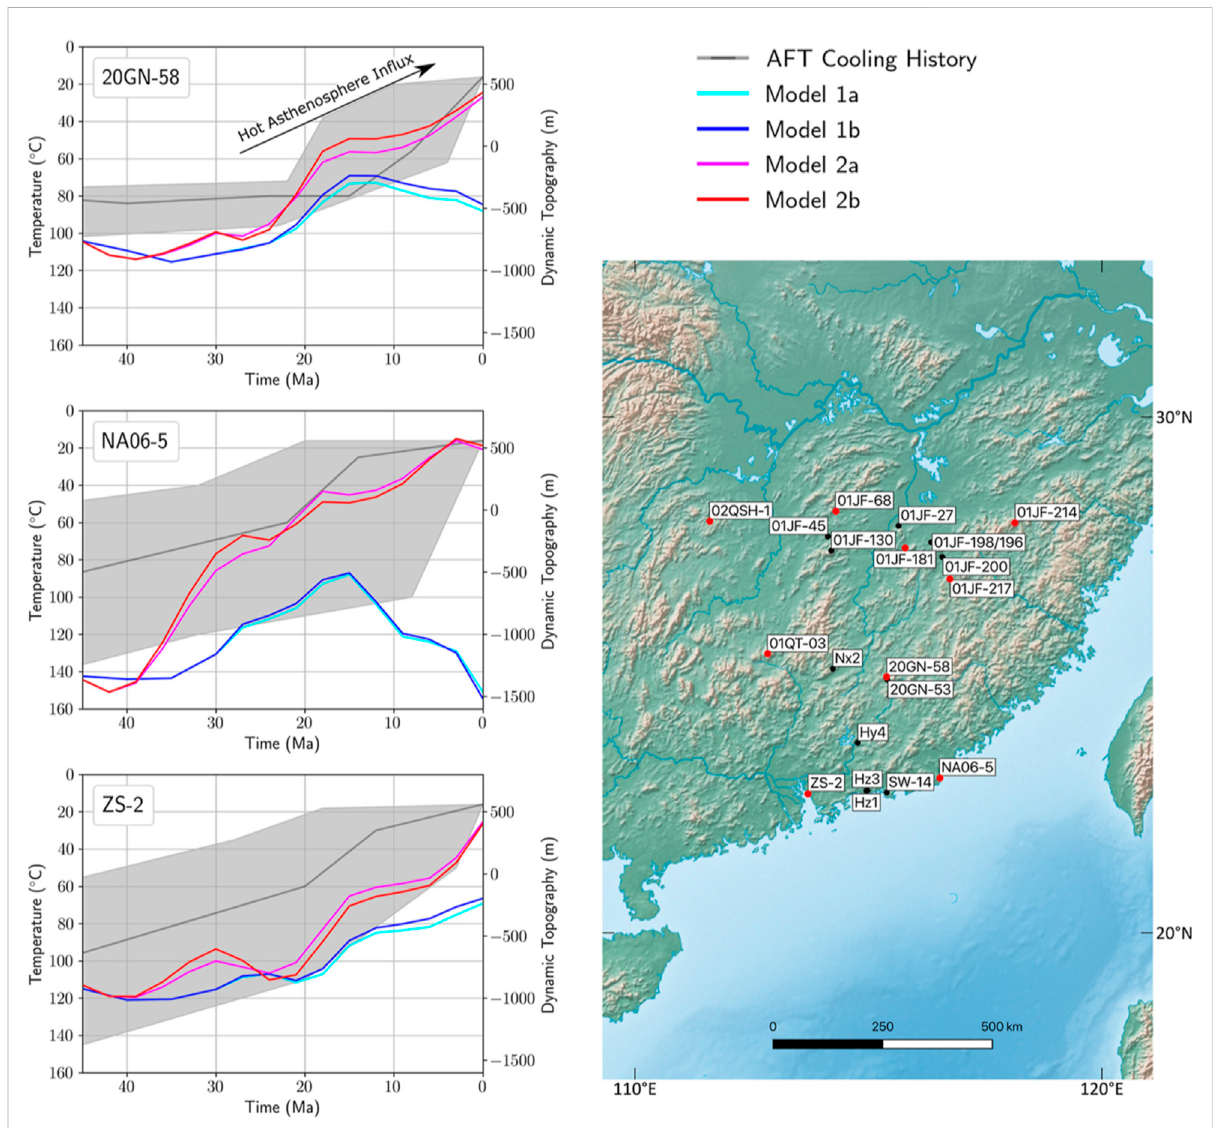
FIGURE 7 Comparison between the dynamic topography predictions of the mantle circulation models of Lin et al. (2020) and the AFT-derived cooling histories published by Wang Y. et al. (2020), Yan et al. (2009) and Li and Zou (2017). Notice the poorer fi t of Models 1a & 1b, in particular for samples closer to the Ryukyu Trench. Samples included here are highlighted in red on the map of sample locations. The full set of samples is included in Supplementary Figures S13 –